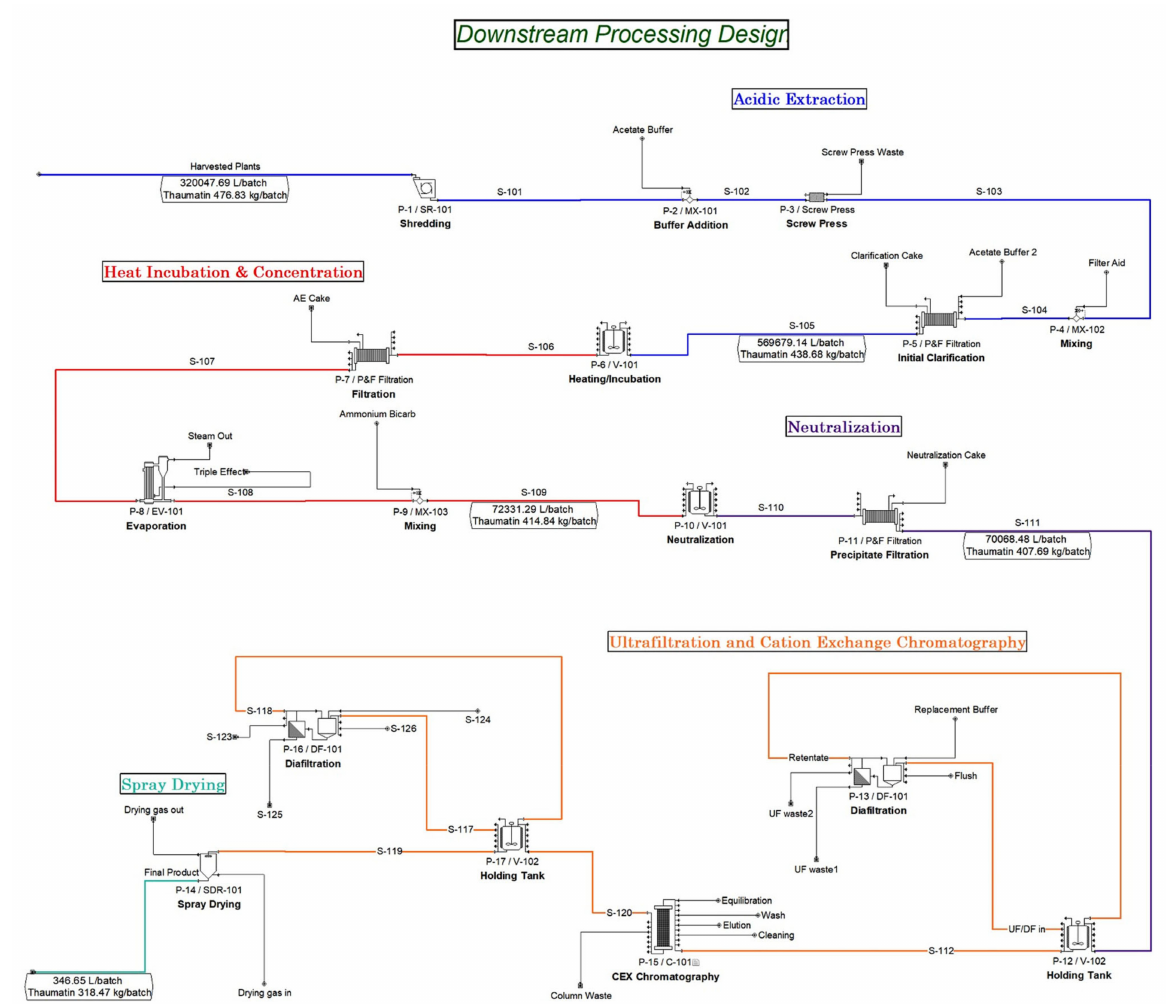
Figure 2. SuperPro Designer model flowsheet for base case downstream processing